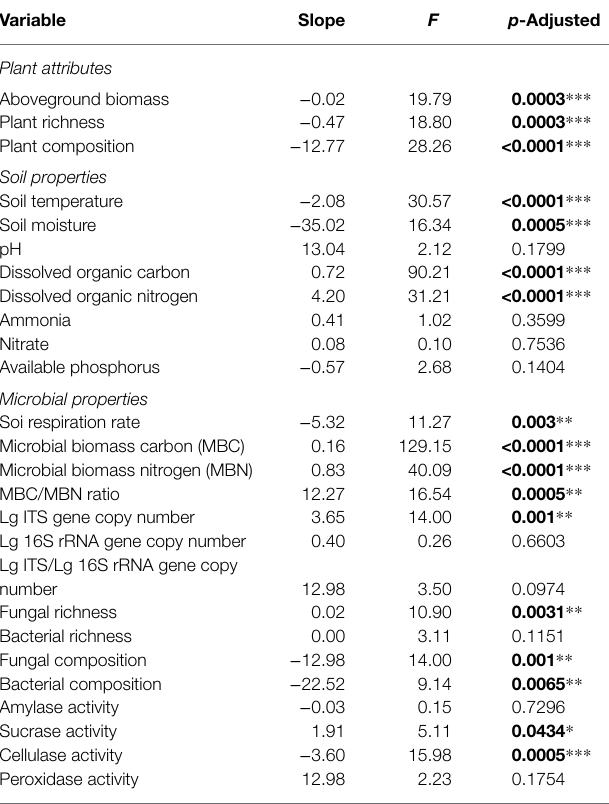
TABLE 1 | Relationships between soil organic carbon content and plant attributes and soil and microbial properties. Variable Slope F p